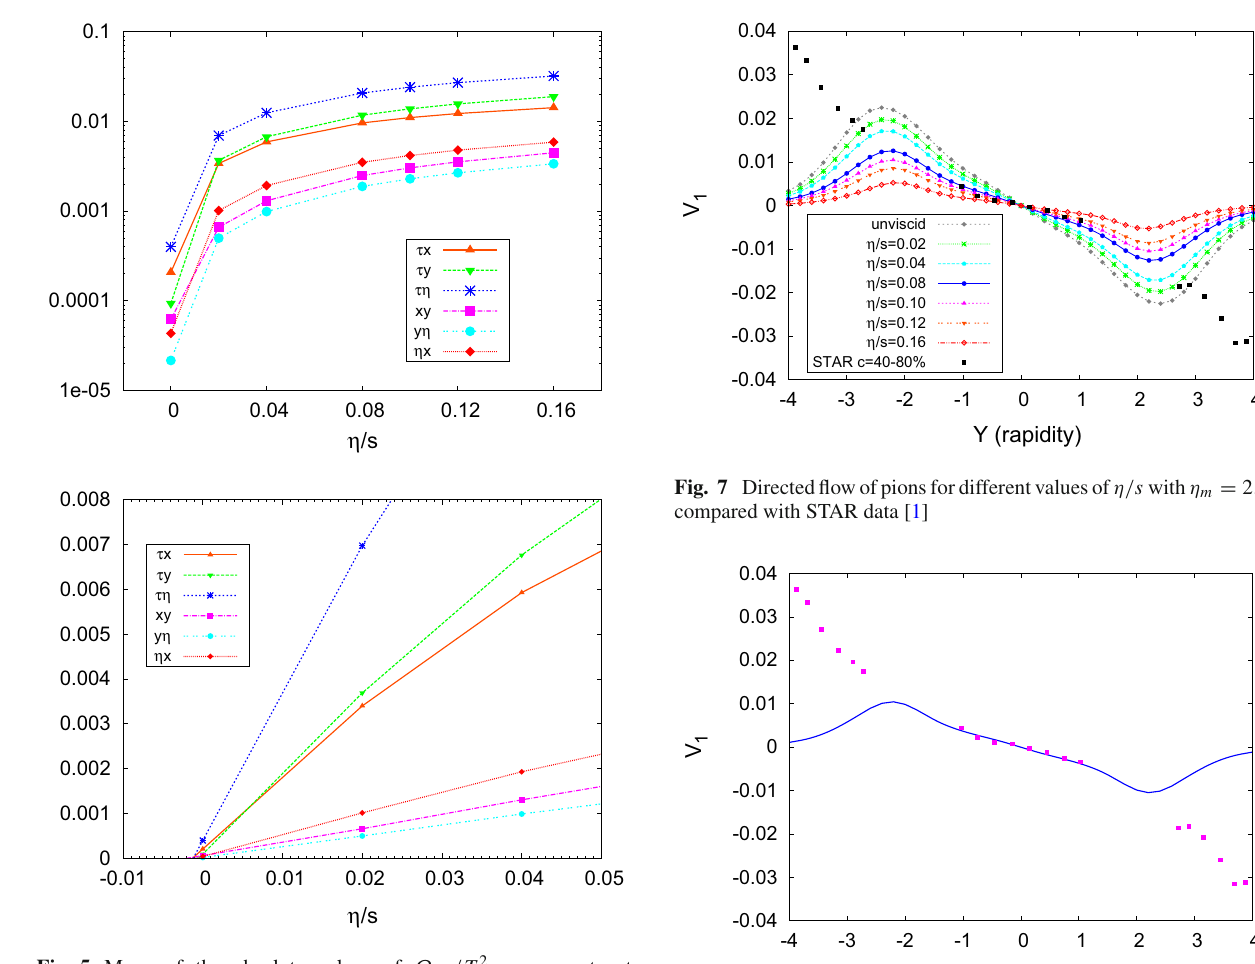
Fig. 5 Mean of the absolute values of Ω μν / T 2 components at the freeze-out hypersurface as a function of η/ s . Note that the Ω ,Ω ,Ω τη have been multiplied by 1 /τ . Upper panel: log scale. x η y η Lower panel: magnification of the region around zero viscosity